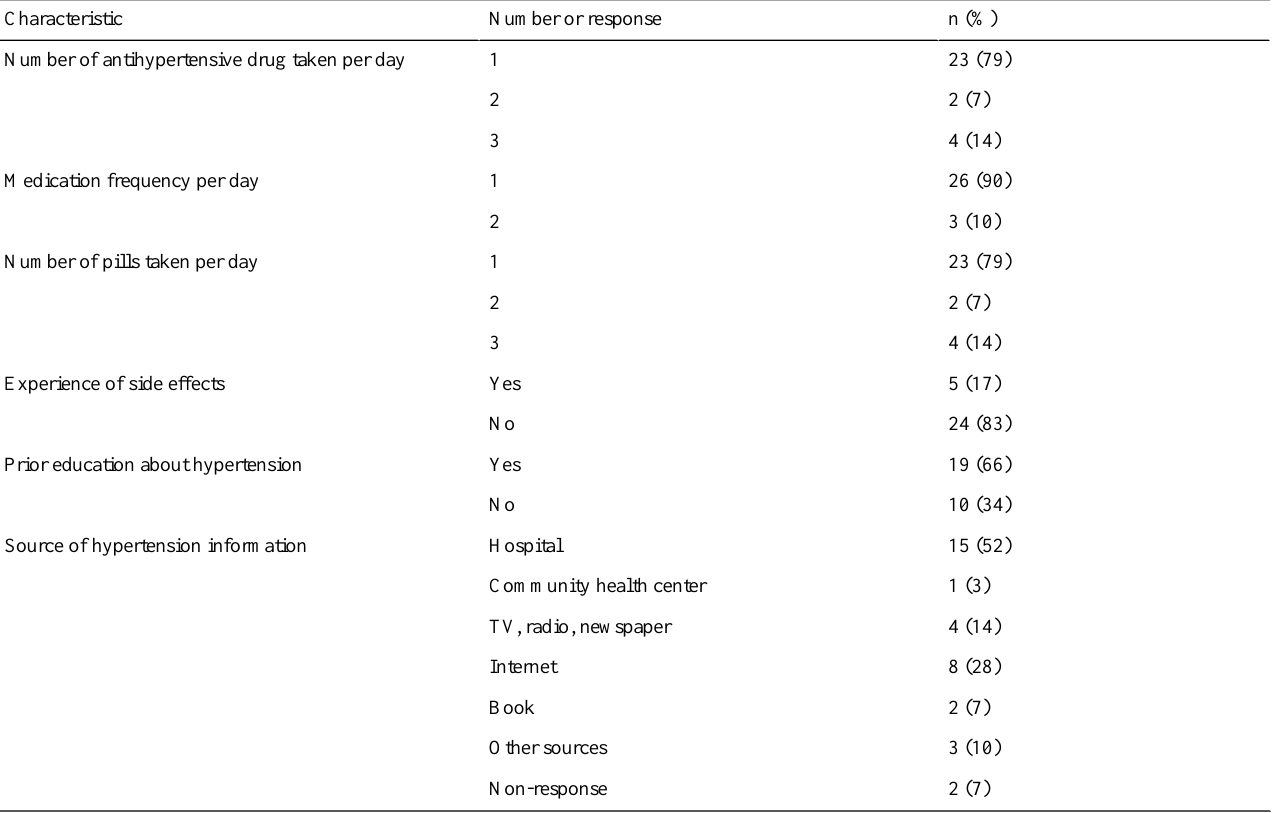
Table 5. Hypertension-related characteristics of the study participants (N=29).